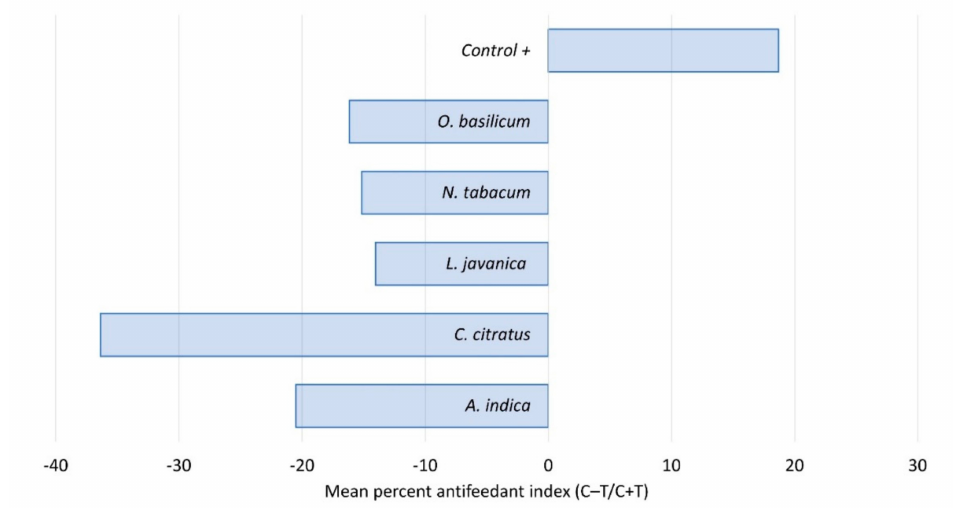
Figure 3. Antifeedant activity of five plant species extracts fed to fall armyworm 2nd instars, showing percent of feeding deterrence after 48 h. C = control; T =